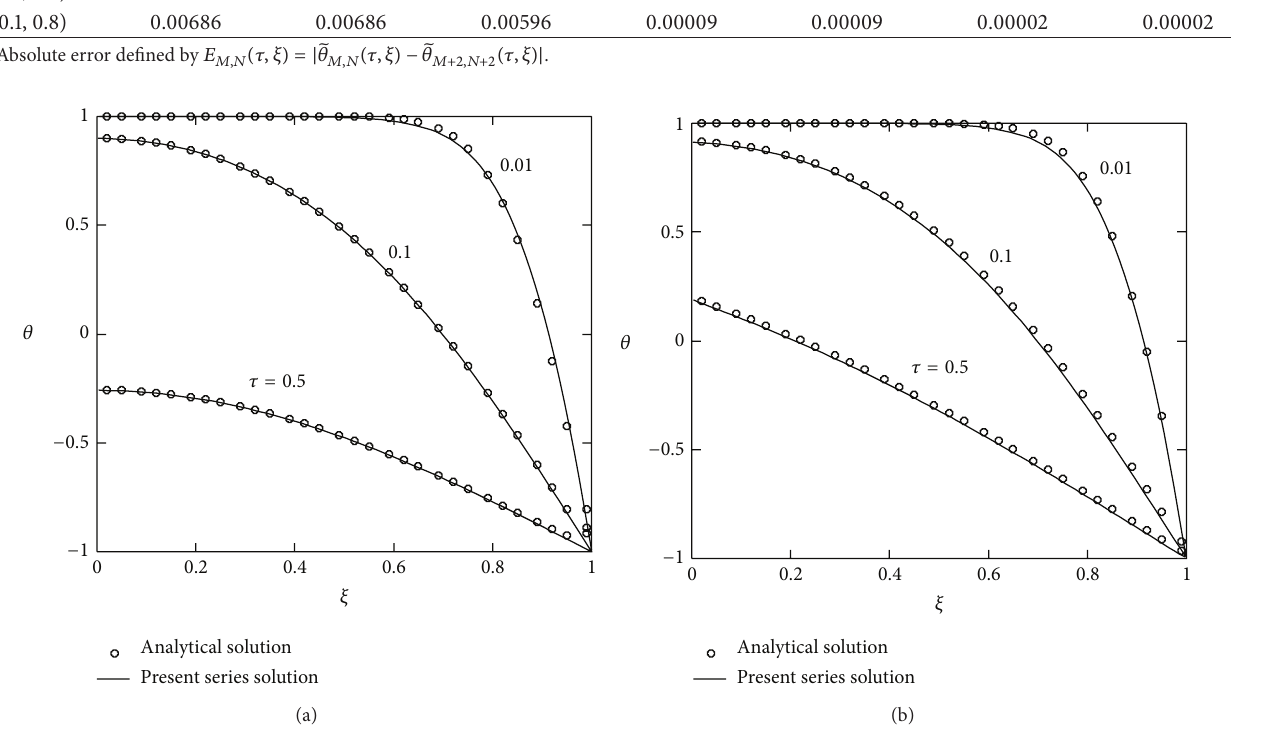
Figure 3: Comparison of transient temperature profiles for different Biot numbers: (a) 𝐵 = 0 and (b) 𝐵 = 1.0